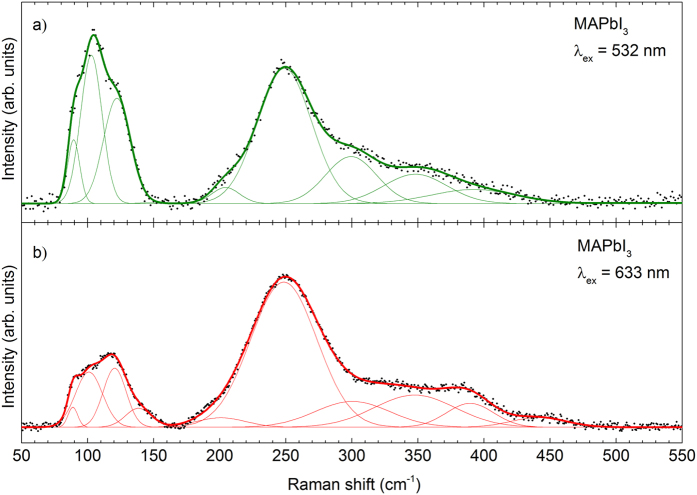
Raman spectra of MAPbI3 thin films with excitation at (a) 532 nm and (b) 633 nm.